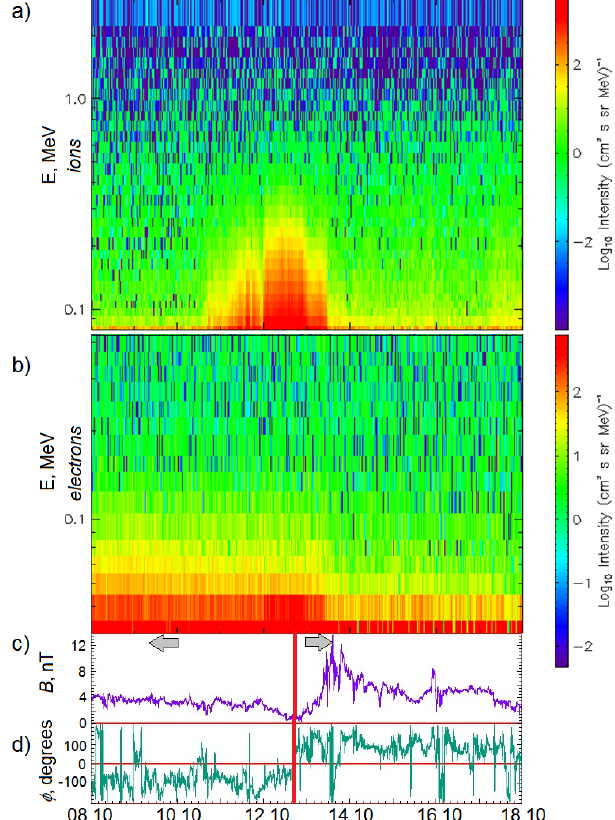
Figure 3. Energy flux of ions (a) and electrons (b) (STEREO-A, spectrograms of energetic particles); the IMF strength (c) and its azimuthal (clock) angle changes (d) during the HCS crossing.